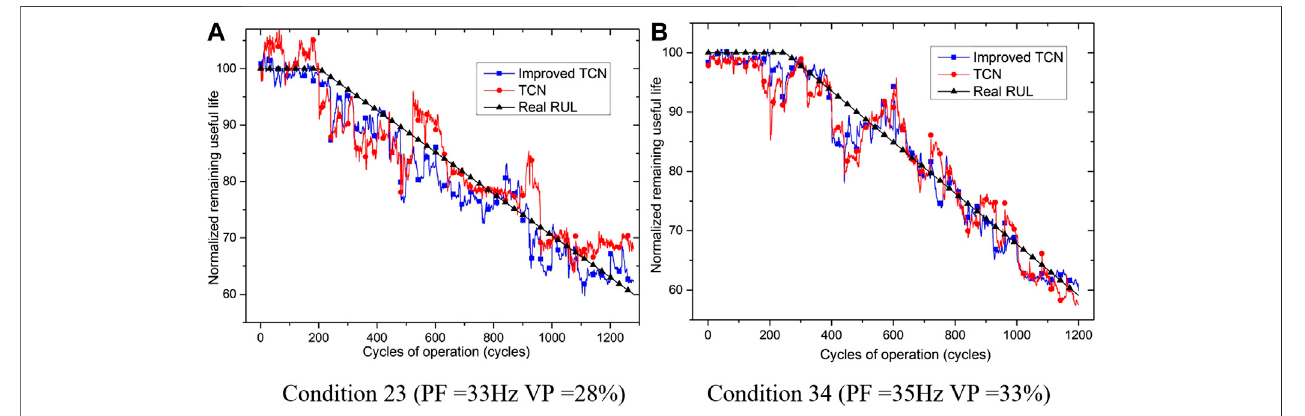
FIGURE 9 | Results of RUL prediction under different operating